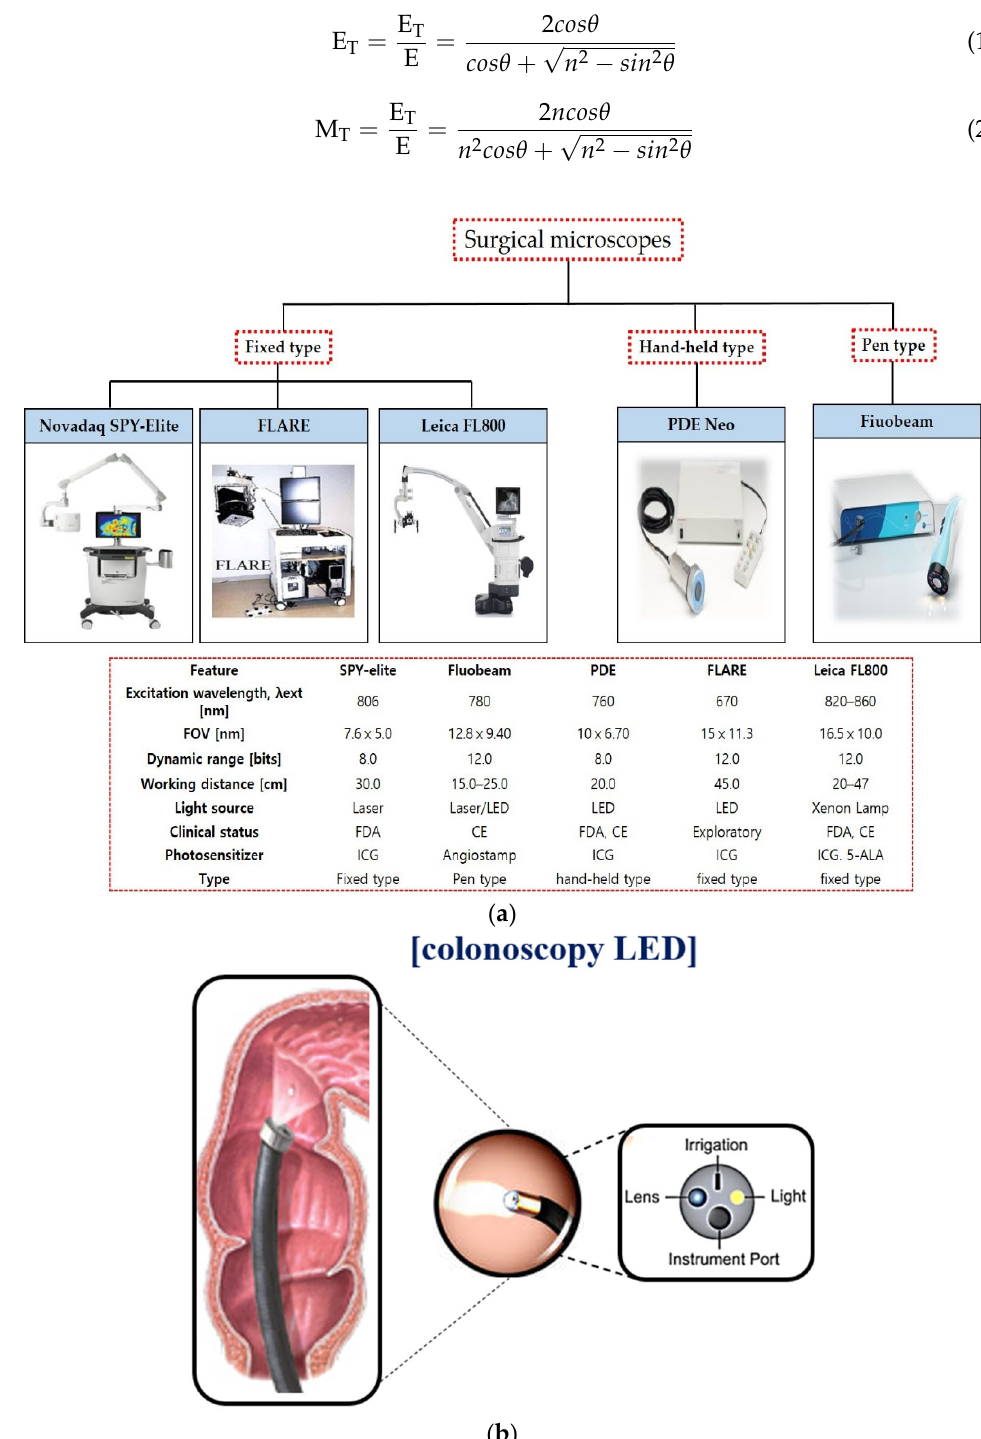
Figure 2. ( a ) Diagnosis process of the surgical fluorescence microscopy system and its ( b ) camera structure.